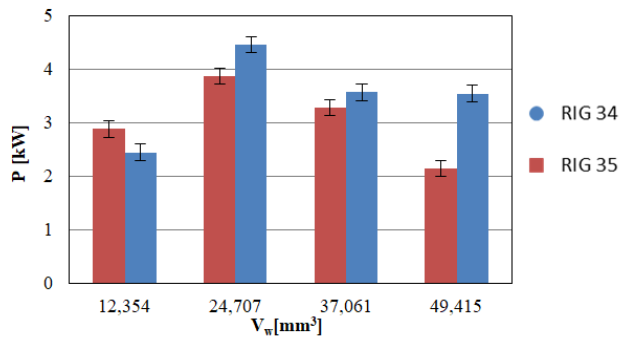
. Figure 10. Power consumption during grinding. Figure 10 . Power consumption during grinding.